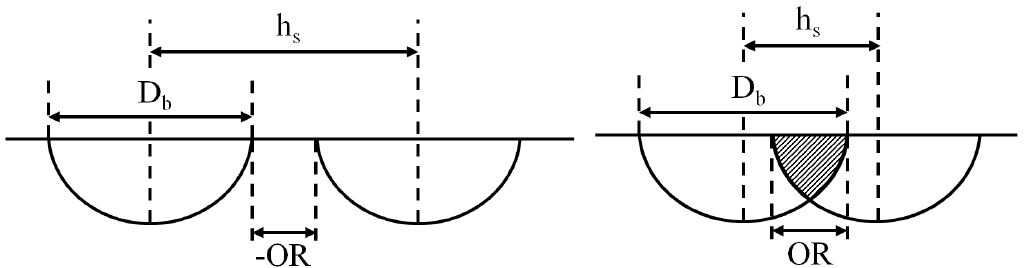
Figure 2. Schematics of the studied laser forming parameters. Table 1. Process parameters.